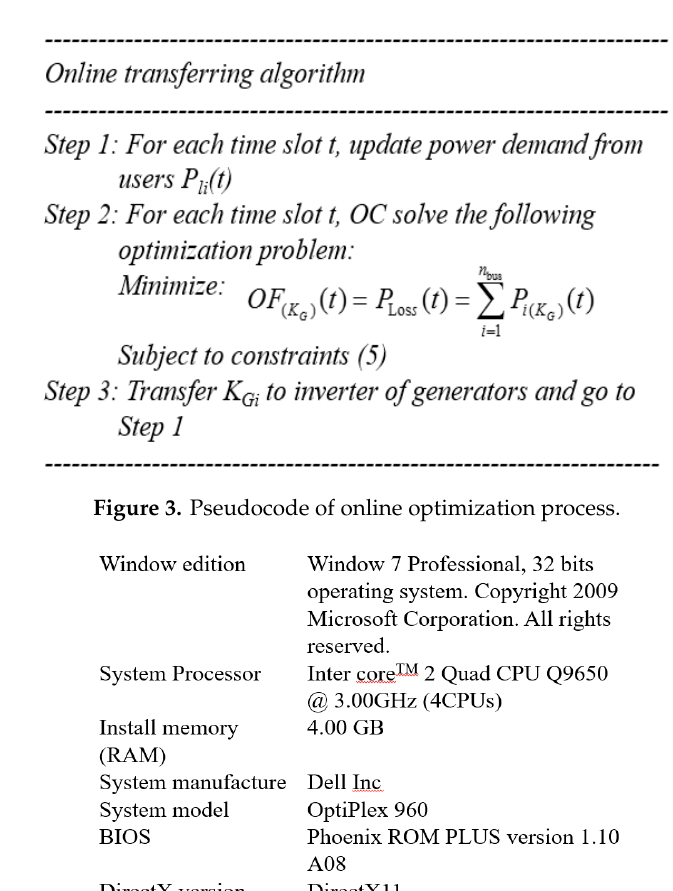
( b ) Figure 6. 9-bus system. ( a ) layout of the test system; ( b ) results of the optimization.